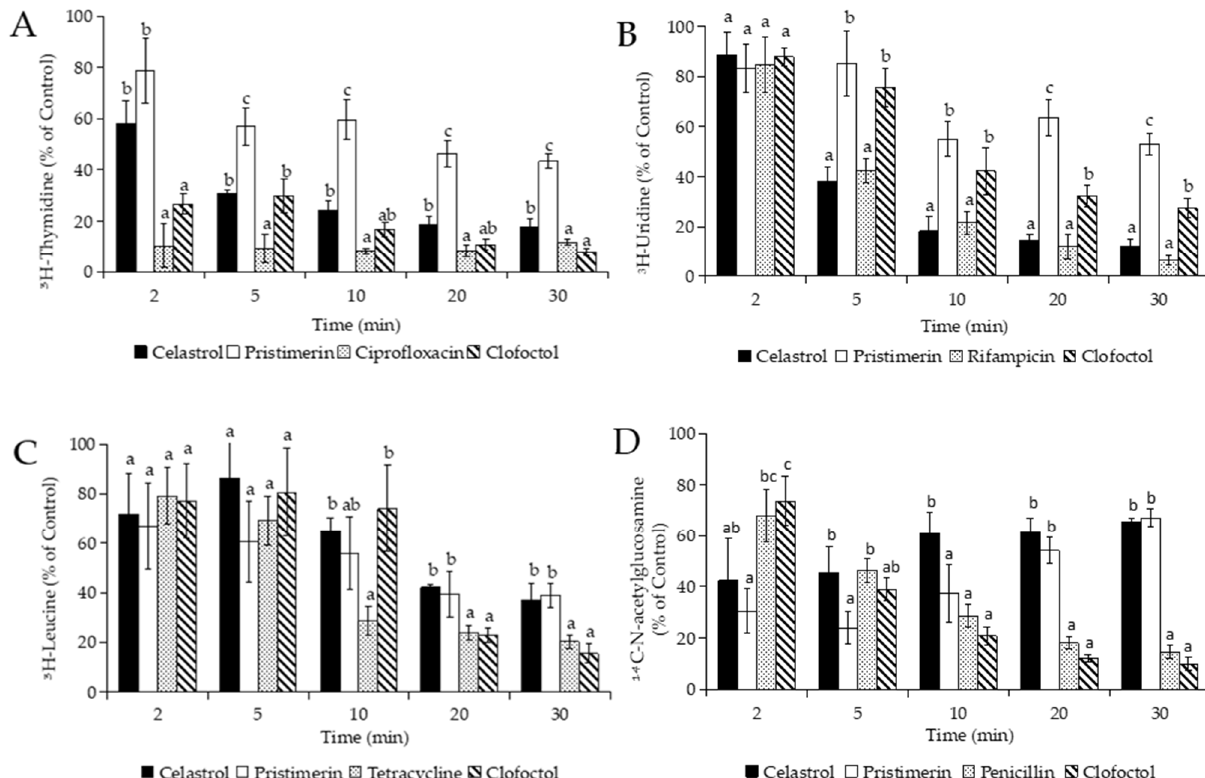
Figure 3. Incorporation of precursor in the synthesis of DNA ( A ), RNA ( B ), protein ( C ), and cell wall ( D ) of B. subtilis cultures in the presence of triterpene methylene quinones (celastrol 3 µg/mL; pristimerin 10 µg/mL), specific inhibitors of each pathway (ciprofloxacin 1.25 µg/mL; rifampicin 0.2 µg/mL; tetracycline 10 µg/mL; and penicillin 30 µg/mL), and clofoctol (5 µg/mL). Data are expressed as percentage (%) of precursors’ incorporation compared to controls without drugs but with the maximum proportion of DMSO. Error bars express SD with n = 3. Different letters above bars mean significant differences between treated cultures ( p < 0.05, one-way ANOVA; Tukey’s test).